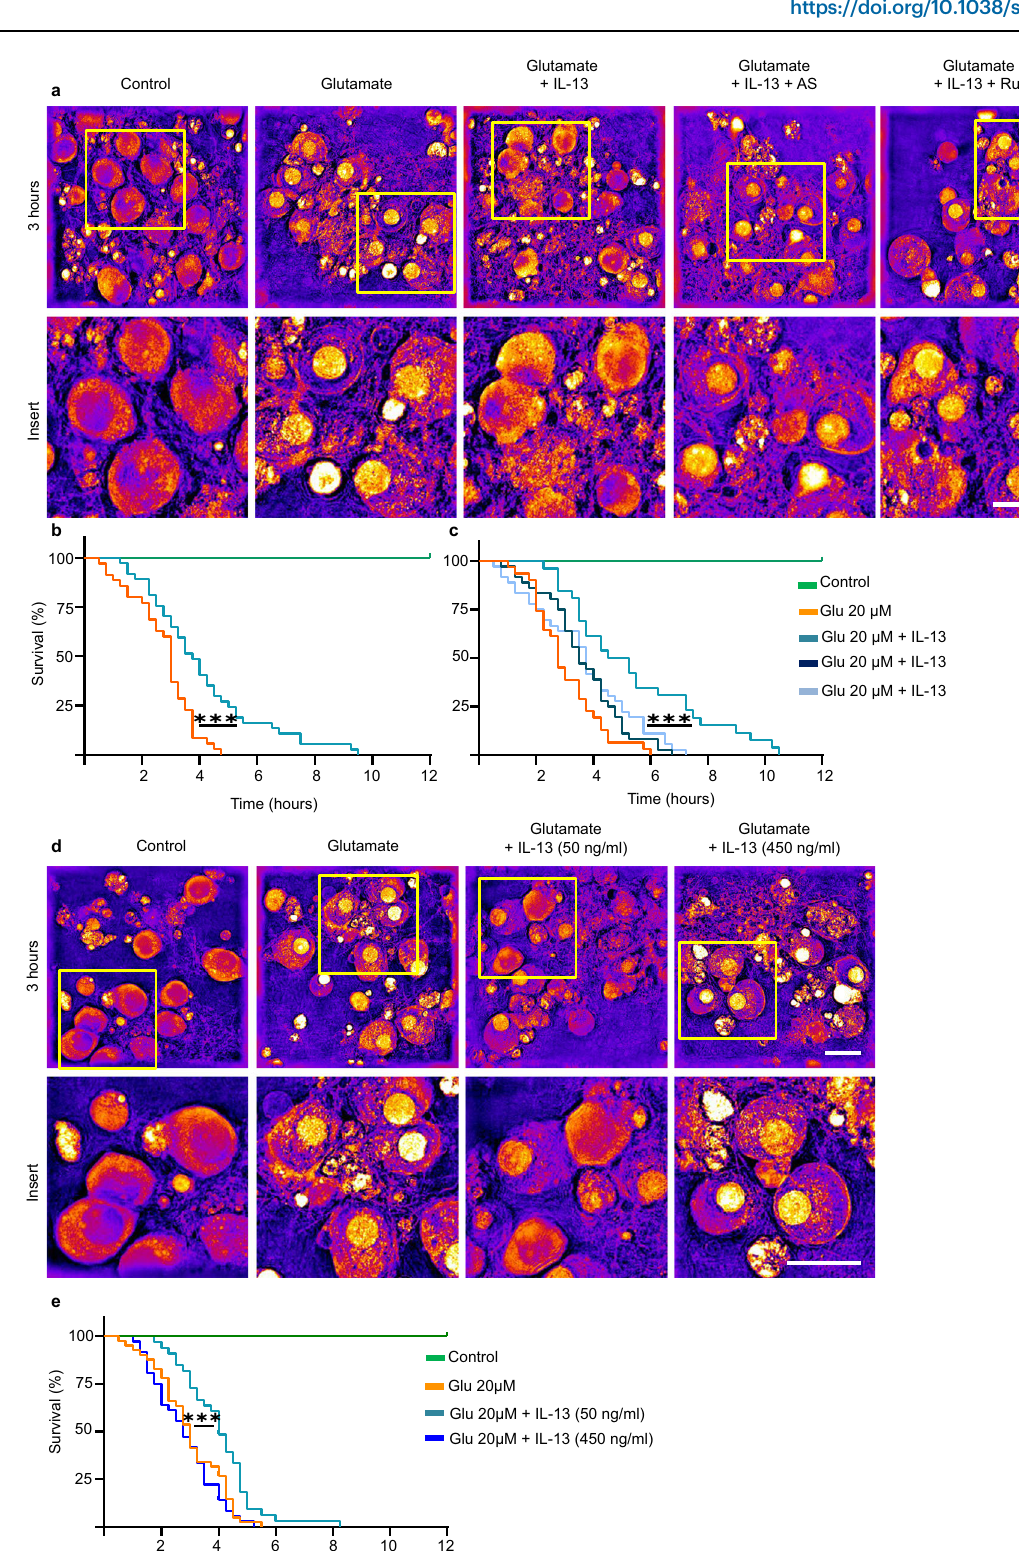
Fig. 8 | IL-13 reduces excitotoxic neuronal death. a – c Signi fi cant reduction of glutamate(20 μ M)inducedneuronaltoxicityafterIL-13treatment(50ng/ml)inrat cortical neurons revealed in holotomography microscopy live imaging ( p =0.0003). Treatment with JAK (Ruxolitinib; 280nM) and STAT6 (AS1517499; 1 μ M) inhibitors show that the protective effects of IL-13 are dependent on a JAK/ STAT6 dependent mechanism (IL-13 vs Rux: p =0.0030; IL-13 vs AS: p =0.0006).